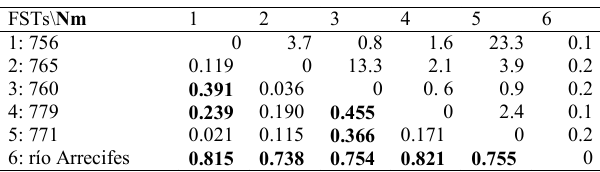
values (below) ST